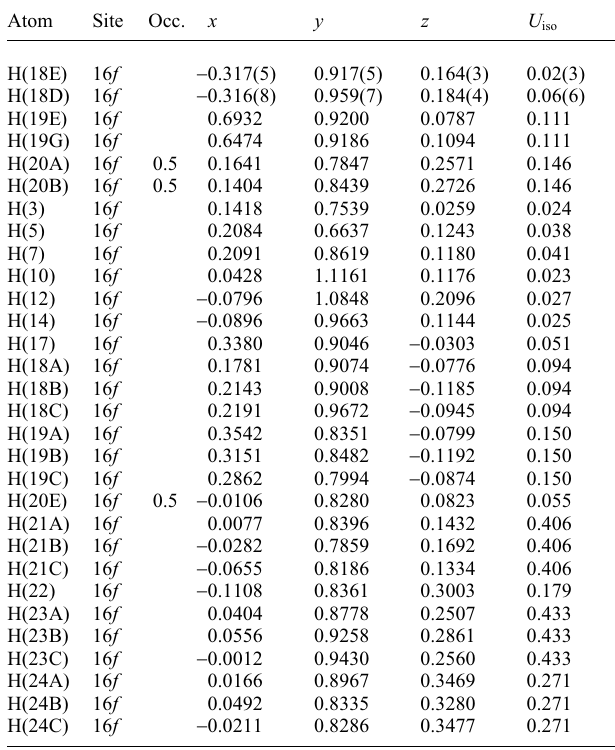
Table 2. Atomic coordinates and displacement parameters (in Å 2 ) . Atom Site Occ.